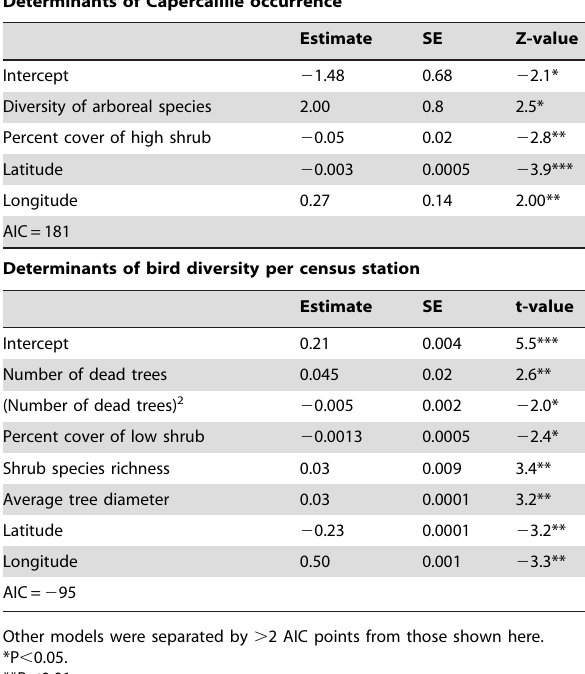
Variable Measurement Species Percentage of tall shrub